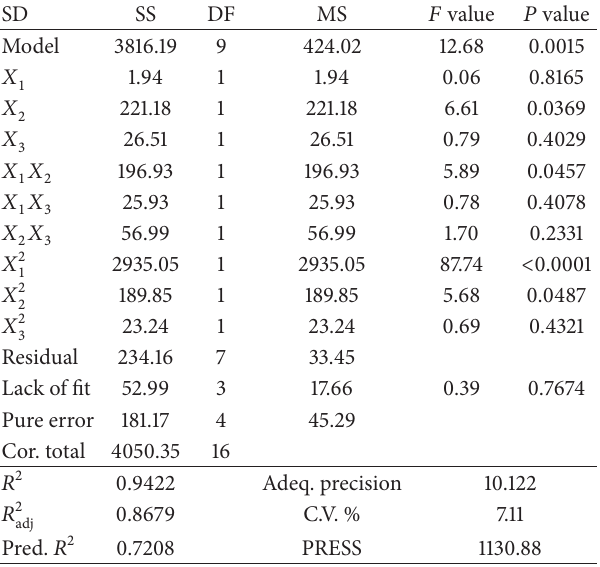
Table 2: Analysis of variance for response surface quadratic polyno- mial model. SD: sources of deviation; SS: sum of squares; DF: degree of freedom; MS: mean square; 𝑅 2 : determination coefficient; 𝑅 2 adj : adjusted determination coefficient; CV %: coefficient of